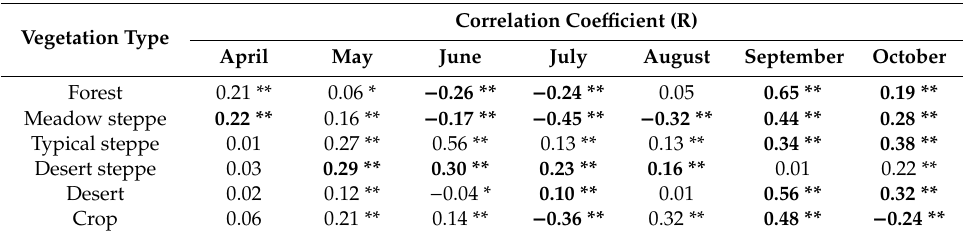
Table 3. Correlations between the CVs of monthly NDVI and those of the temperature in the previous month for di ff erent biomes in Inner Mongolia from 1982 to 2015.